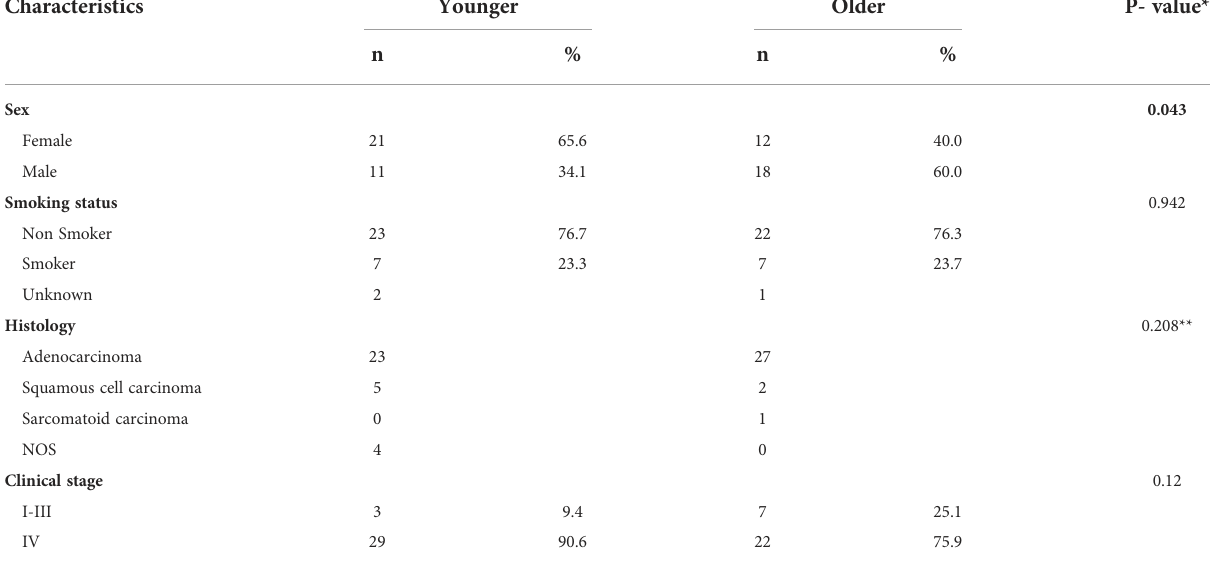
TABLE 1 Comparison in clinical characteristics between younger and older patients with NSCLC.